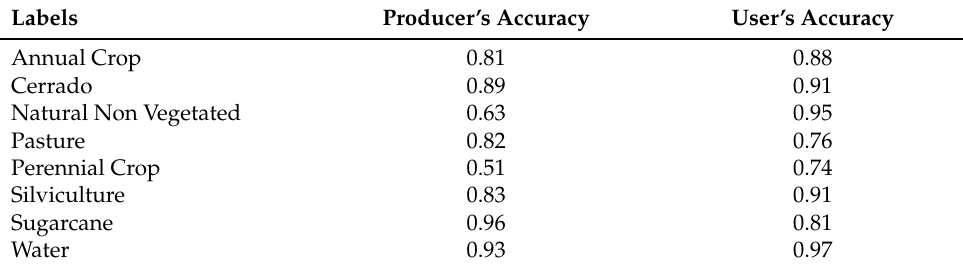
Table 1. Area-weighted classification